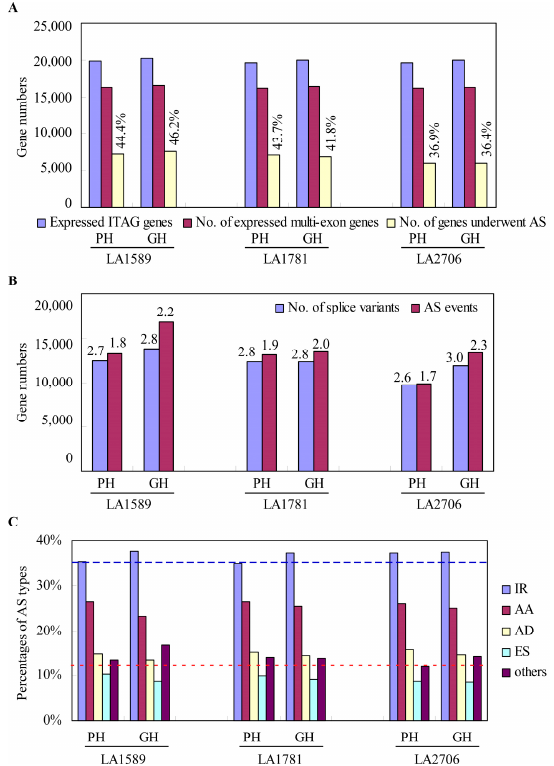
Figure 2. Alternative splicing (AS) response to distinct growth environments. ( A ) The number of expressed genes, genes with multi-exons and those that underwent AS in the seedlings grown under GH and PH conditions. AS frequencies were shown in the above the bar charts representing the number of genes that underwent AS; ( B ) The number of splice variants and AS events predicted. The numbers above the bar charts indicated the number of splice variants and AS events per gene; ( C ) Frequencies of AS types in transcriptome of GH and PH seedlings of LA1589, LA1781 and LA2706. The blue and red dotted lines indicate the lowest frequencies of intron retention (IR) and “others” types, respectively.